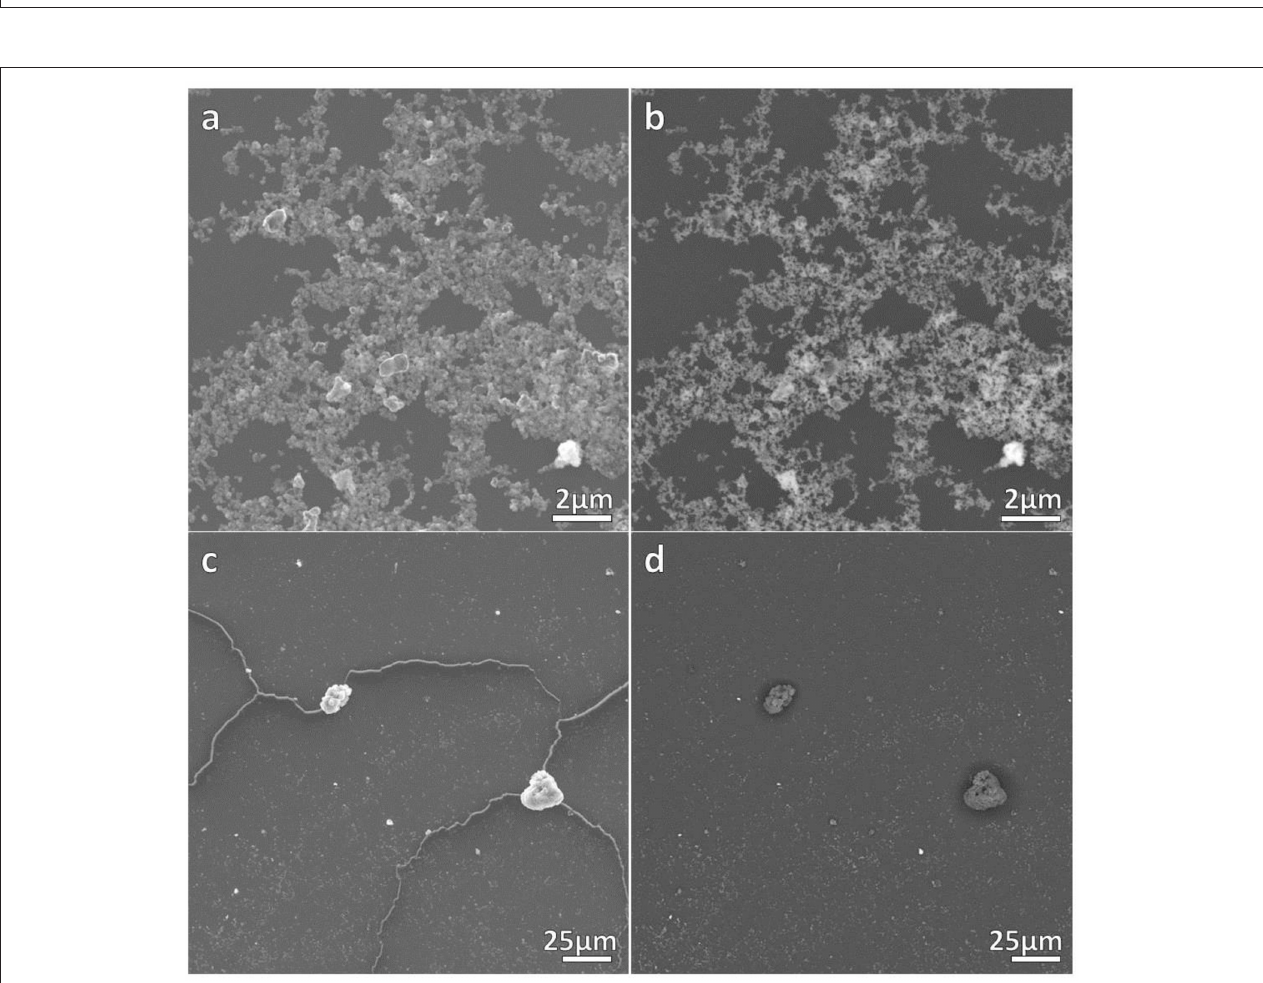
FIGURE 2 | SEM micrographs of DNO_1 sample. (a,c) contain topographical micrographs recorded with secondary electrons, while (b,d) contain Z-sensitive micrographs recorded with backscattered electrons.